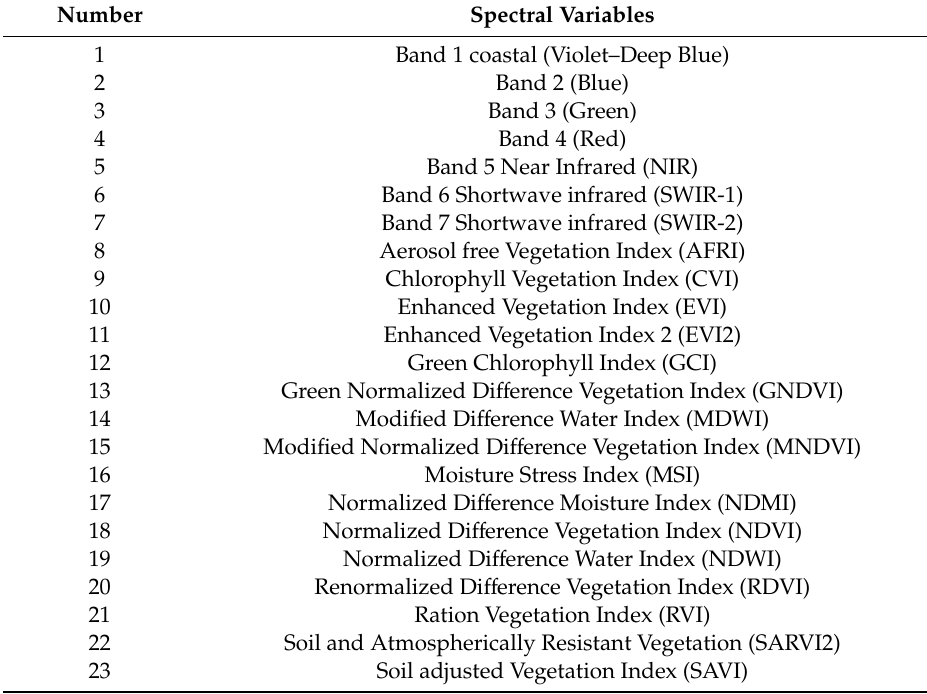
Table 3. Landsat 8-OLI Spectral Variables for Classification of Polluted Vegetation and